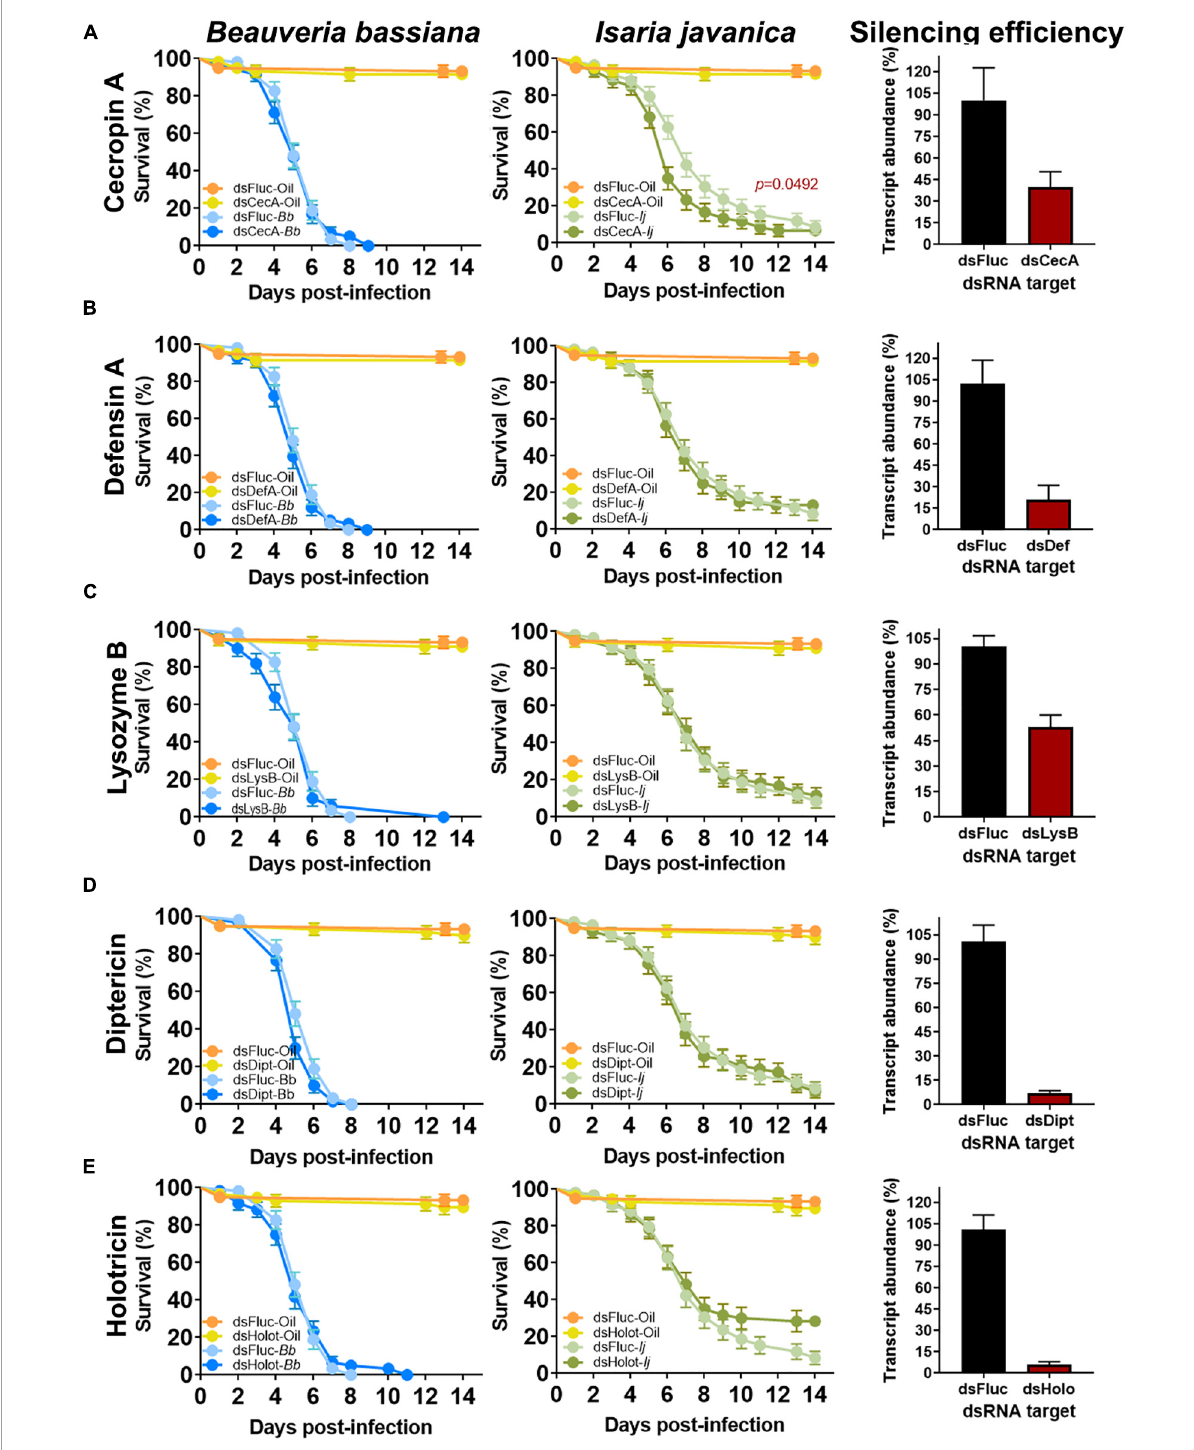
FIGURE3 Effect of single AMP depletion on the survival of mosquitoes infected with entomopathogenic fungi. Silencing efficiency and survival curves of mosquitoes infected with B. bassiana and I. javanica post RNAi-knockdown of cecropin A (A) , defensin A (B) , lysozyme B (C) , diptericin (D) , and holotricin (E) . Survival curves represents at least four independent experiments and data was analyzed with Log-rank Test (GraphPad Prism 9). Error bars indicate the